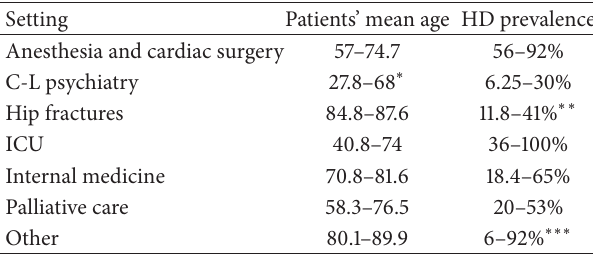
Table 8: HD prevalence in different